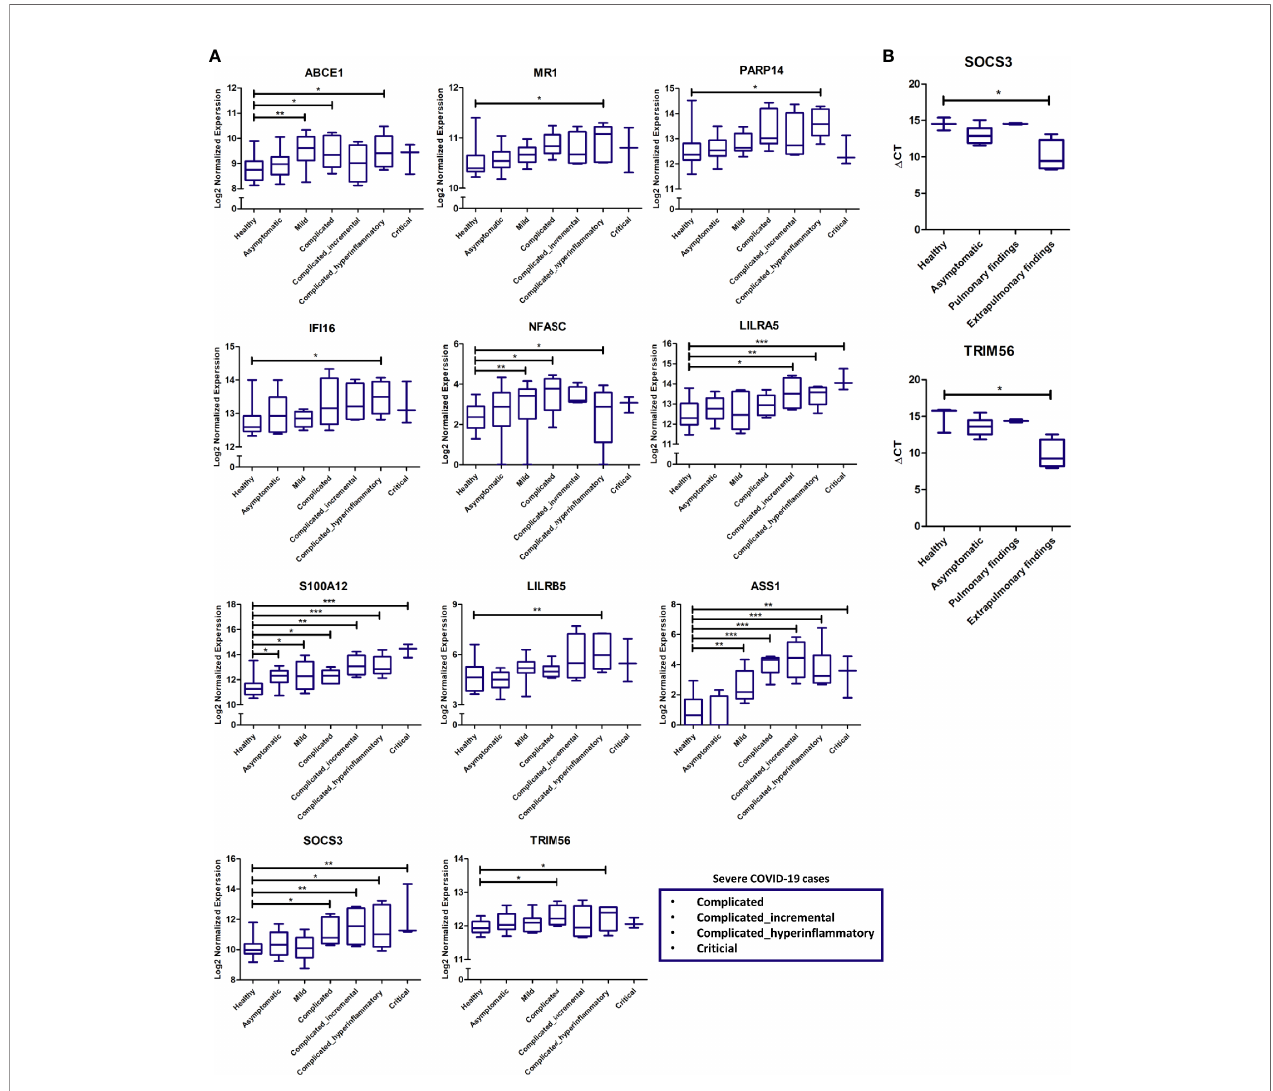
FIGURE 6 | (A) Gene expression cross-validation of identi fi ed uniquely and commonly expressed immune putative biomarkers across pulmonary and extrapulmonary tissues using RNA sequencing dataset of whole blood samples from healthy donors and asymptomatic, mild, and severe COVID-19 patients. (B) Gene expression cross-validation of commonly expressed immune putative biomarkers across pulmonary and extrapulmonary tissues using qRT-PCR analysis of blood plasma samples from 3 healthy donors as well as 6 asymptomatic COVID-19 patients, 2 severe COVID-19 patients with pulmonary fi ndings (pulmonary fi ndings) only, and 4 severe COVID-19 with pulmonary and extrapulmonary fi nding (extrapulmonary fi ndings). * represents p-value < 0.05; ** represents p-value < 0.01; *** represents p-value < 0.001; analyzed using unpaired t-test statistical